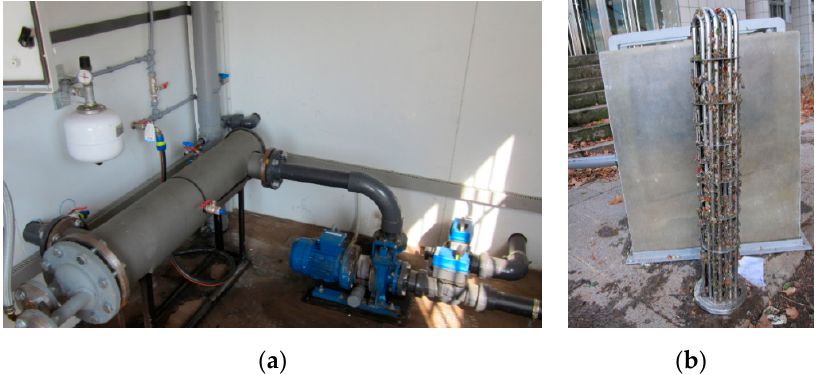
Figure 9. ( a ) Heat exchanger located in the control house; ( b ) Dismantling of heat exchanger due to clogging problems.